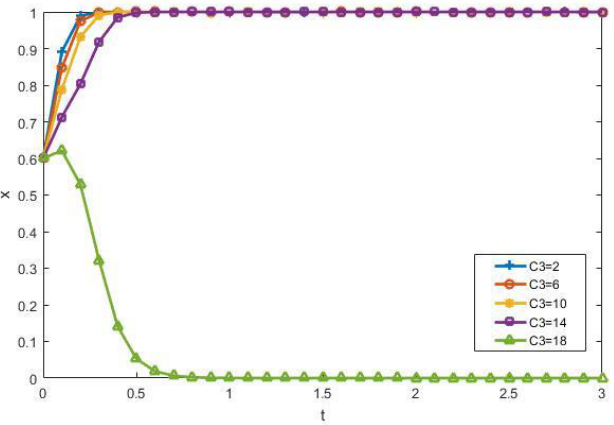
Figure 7. The impact of C 3 on the evolutionary results.